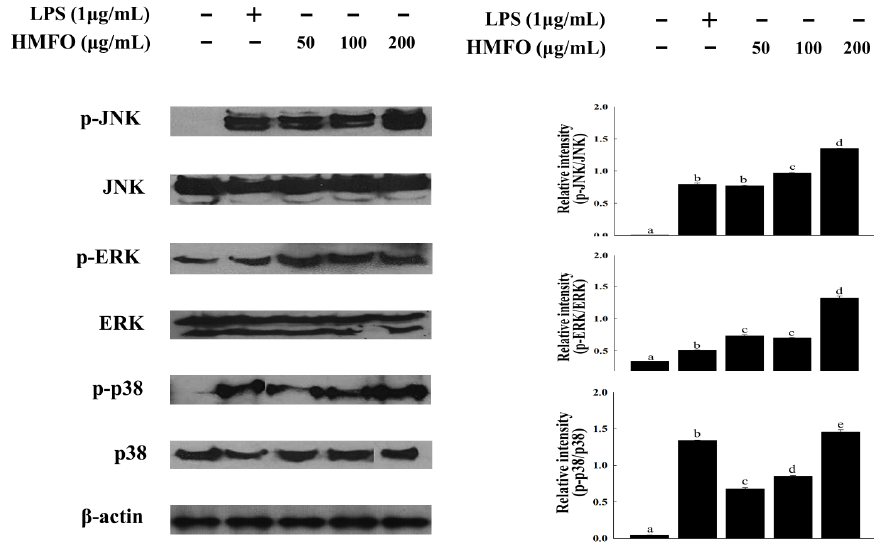
Figure 7. HMFO induced mitogen ‐ activated protein kinase (MAPK) phosphorylation in RAW 264.7 macrophages. Cells were stimulated with HMFO (50, 100, or 200 μ g/mL) or LPS (1 μ g/mL). Phosphorylated ‐ c ‐ June N ‐ terminal kinase (JNK), phosphorylated extracellular signal regulated kinase (ERK), phosphorylated p38, and β‐ actin isolated from cell lysates were determined by immunoblotting analysis. Values with the different letters are significantly different ( p < 0.05).